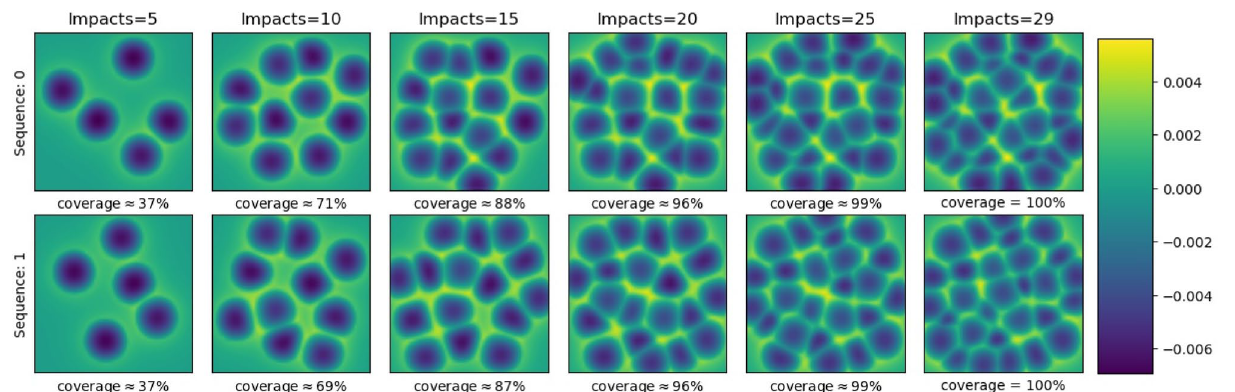
ples, Table 1. Each sample is a surface representation obtained under the shot peening treatment; Armco pure iron, sample volume 1.5 × 1.5 × 1.0 mm 3 . The FE model has been published and experimentally validated in 28 for carburizing steel. It has been applied in 25 for Armco pure iron. Each run of the FE model produces one sequence of sample surfaces, Fig. 1. A sequence starts with an untreated plane surface and adds shot peening impacts. Each sequence yields between 6 and 7 surface samples of increasing shot peening coverage. Each surface sample is a surface snapshot during the FE run labelled by one of 6 stages. The stages at which surface snapshots are taken by the FE code correspond to ranges of impact numbers, Table 1. Based on the impacts, we calculate the shot peening coverage of the surface. In this calculation, we locate the local surface minima on the height displacement map which represent an estimation of shot impact centres. Each shot is estimated to shot peen a surface circle of diameter 0.055 mm. To estimate the coverage percentage, the macro circle of diameter 0.2 mm is considered. We assign each of the 92 samples, according to estimated sample coverage, to one of 6 bins. Bins 0 to 4 contain 15 samples each. The 5th bin contains 17 samples. The bins are labelled using the mean coverage percentages of each bin, this will be the class label for the analysis. Each individual FE surface sample is given on a regular, unevenly spaced 74 × 74 surface grid, but different grids may be slightly shifted with respect to each other. Hence, for comparison purposes, all the values are inter- polated on a common 74 × 74 grid being the input for further analysis. For calculating the ISO 25178 parameters, the interpolated FE surfaces are postprocessed to give a roughness surface by applying a low-pass Gaussian filter as L-filter (utilizing Fast Fourier transformation) for the cut-off wavelength of 0.8 mm, see ISO 16610:61 29 . Due to the construction of the numerical model used, applying an S-filter is not required.